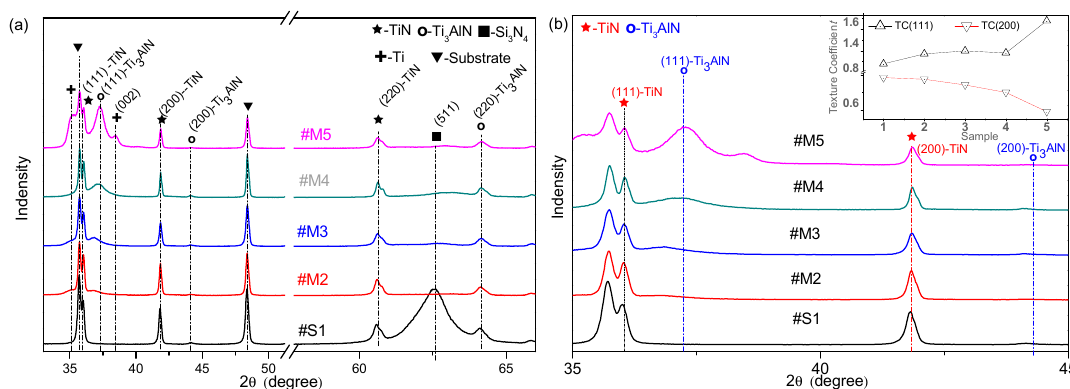
Figure 5. ( a ) The X-ray di ff ractometry patterns of monolayer TiAlSiN and TiAlSiN / Ti multilayer coatings ( b ) Enlargement of (111) and (200)